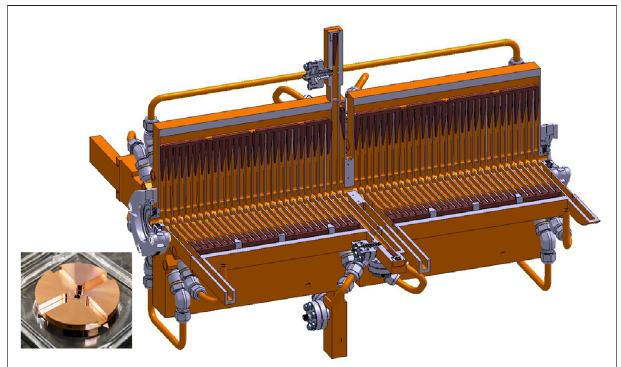
FIGURE 5 | Left: The basic assembly block of the CLIC structure with four waveguides providing HOM damping. Right: Assembly drawing of the double-structure acceleration unit (Image credit: CLIC) [13].